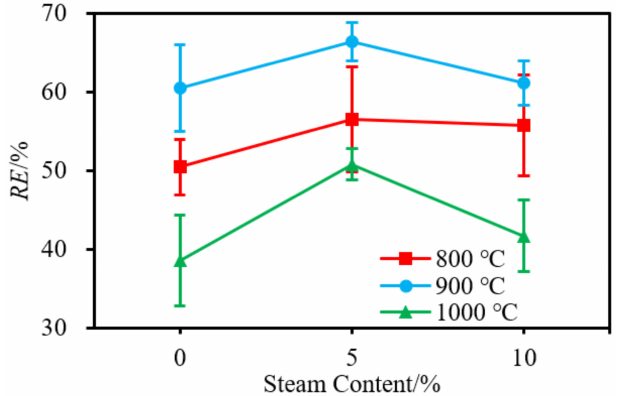
Figure 4. Fixation of phosphorous in the ash of SS during combustion with extra 5–10%